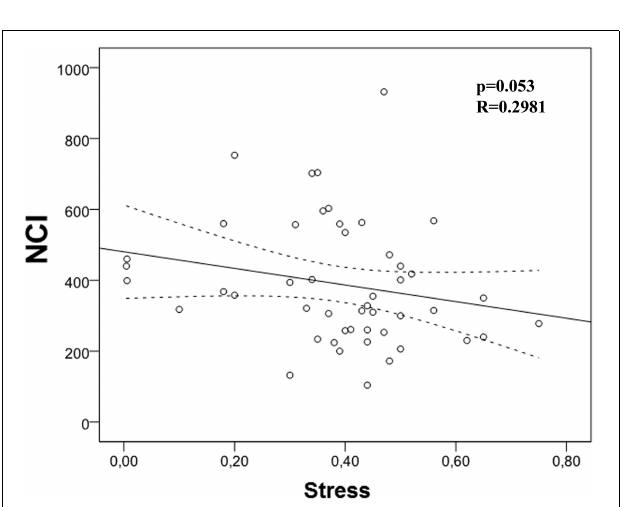
FIGURE 3 | Correlation between Neutrophil Chemotaxis Index (NCI) and stress. There is a strong trend correlation between NCI and stress ( p = 0.053, r = -0.281).